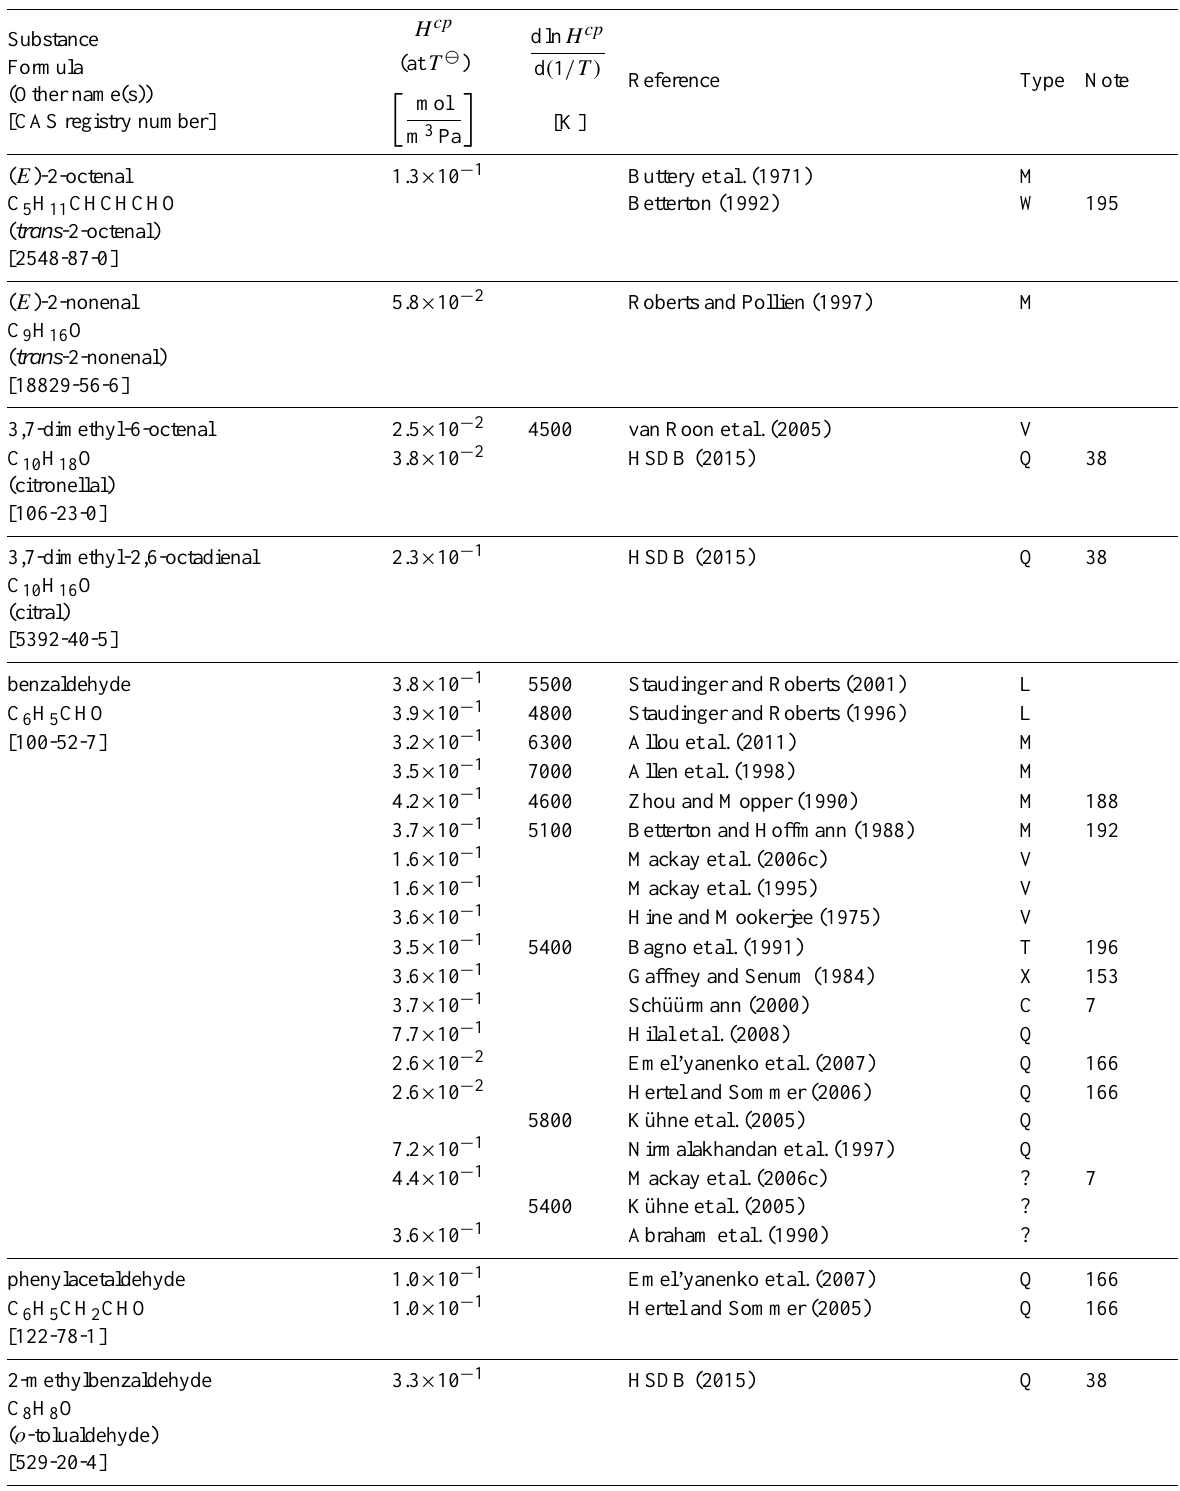
Table 6: Henry’s law constants for water as solvent